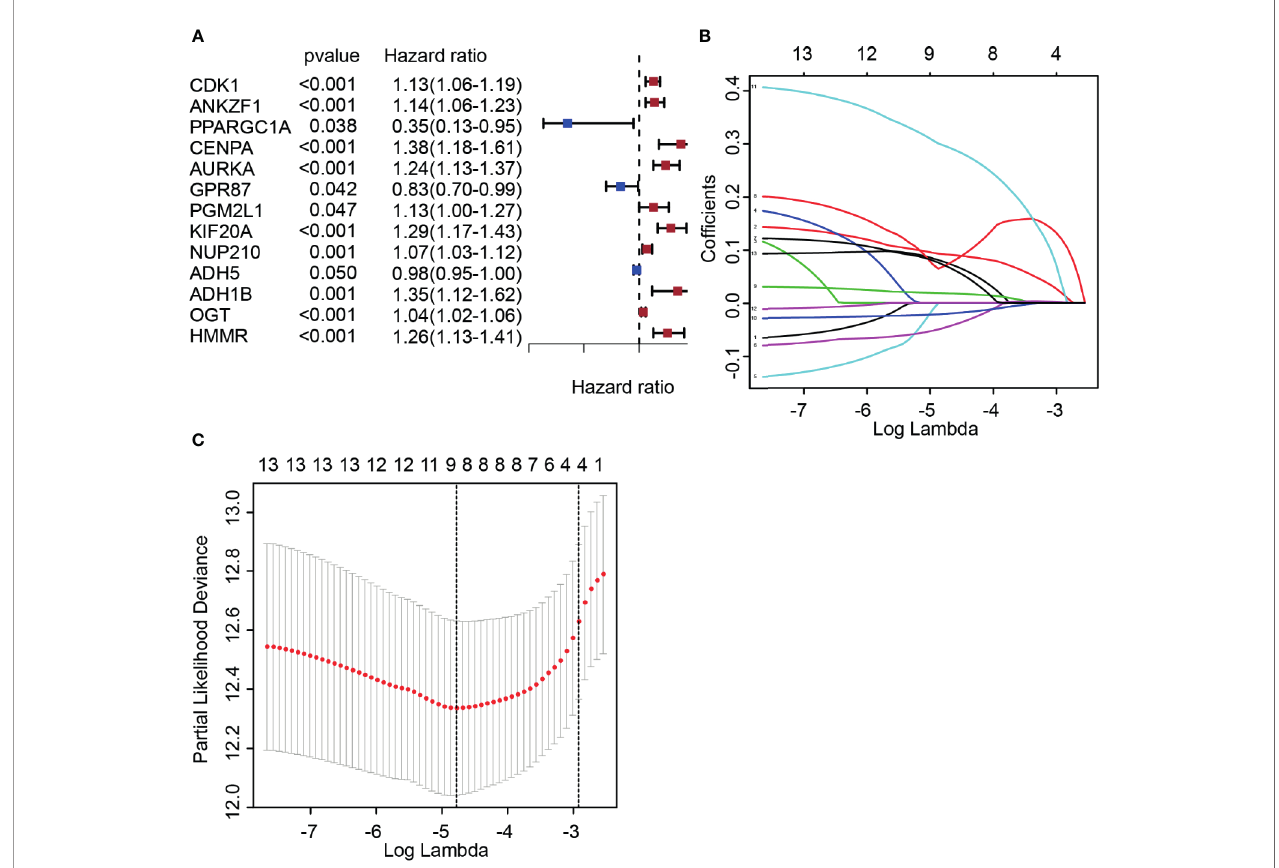
FIGURE 2 | Identifying candidate molecules associated with the prognosis of prostate cancer patients. (A) Univariate Cox regression analysis of glycolysis- associated genes. (B, C) Determination of the best penalty value ( − 5 < l < − 4). LASSO regression of screening glycolysis-associated genes with patients ’